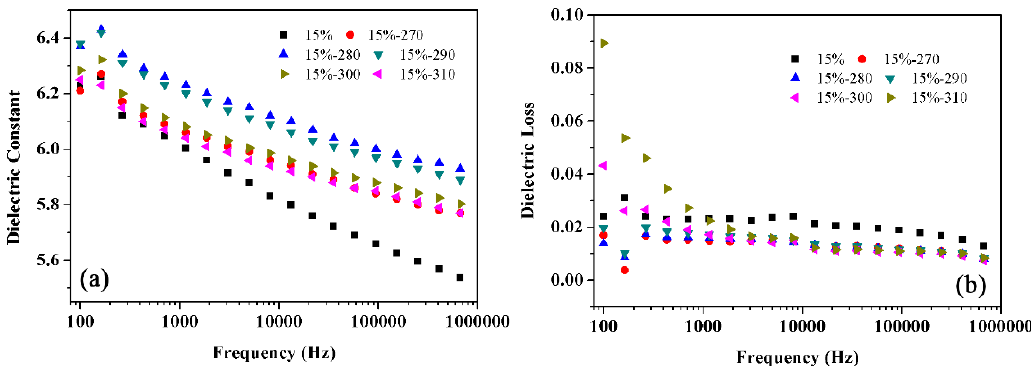
Figure 11. Dielectric constant ( a ) and dielectric loss ( b ) of BT@ZnPc-GO-1/PEN films after isothermal annealing at 200, 270, 280, 290, 300 and 310 °C for 2 h. annealing at 200, 270, 280, 290, 300 and 310 ◦ C for 2